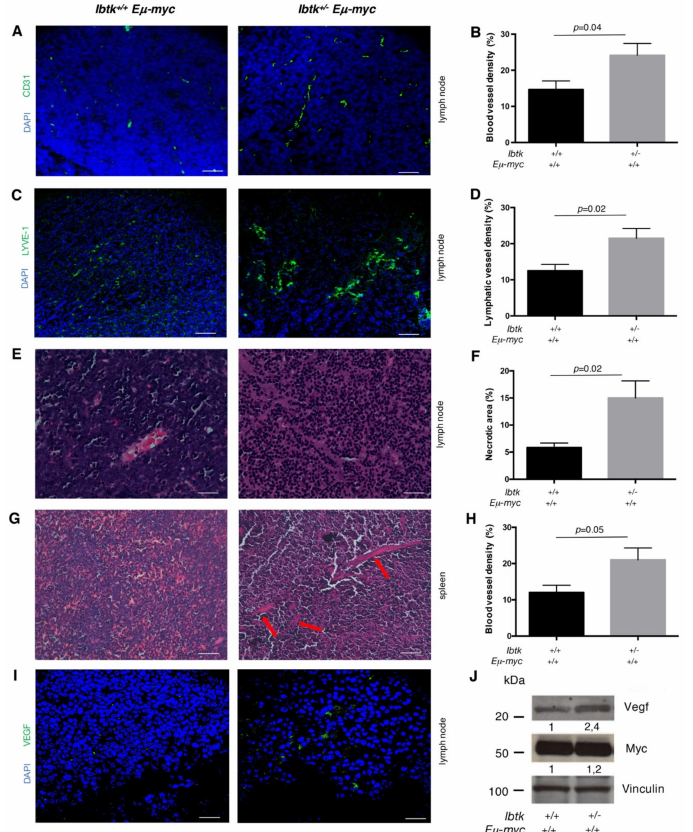
Figure 2. IBTK haploinsu ffi ciency results in increased tumor vascularization and tissue necrosis. A. Sections of tumor lymph nodes of Ibtk +/+ E µ -myc and Ibtk +/ - E µ -myc mice stained for CD31 (green) to visualize blood vessels, and analyzed by confocal microscopy. A representative image is shown. Scale bars: 150 µ m. Magnification 200 × . B. Quantitation of blood vessel density in cancerous lymph nodes of Ibtk +/+ E µ -myc ( n = 6) and Ibtk +/ - E µ -myc ( n = 6) mice. Values are the mean ± SEM. C. Sections of tumor lymph nodes of Ibtk +/+ E µ -myc and Ibtk +/ - E µ -myc mice stained for LYVE-1 (green) to visualize lymphatic vessels, and analyzed by confocal microscopy. A representative image is shown. Scale bars: 150 µ m. Magnification 200 × . D. Quantitation of the lymphatic vessel density in the tumor lymph nodes of Ibtk +/+ E µ -myc ( n = 6) and Ibtk +/ - E µ -myc ( n = 6) mice. Values are the mean ± SEM. E. Sections of tumor lymph nodes stained by hematoxylin / eosin. Representative images of tumor tissues are shown. Scale Bars: 75 µ m. Magnification 400 × . F. Quantitation of necrosis levels was estimated as a percentage of the total area of tumor lymph nodes of Ibtk +/+ E µ -myc ( n = 6) and Ibtk +/ - E µ -myc ( n = 6) mice. Values are the mean ± SEM. G. Spleen sections of sick Ibtk +/+ E µ -myc and Ibtk +/ - E µ -myc mice stained by hematoxylin / eosin. Red arrows indicate marked vascularization in Ibtk +/ - E µ -myc mice. Scale bars: 150 µ m. Magnification 200 × . H. Quantitation of the vessel density in the spleen of Ibtk +/+ E µ -myc ( n = 6) and Ibtk +/ - E µ -myc ( n = 6) sick mice. Values are the mean ± SEM. I . Sections of tumor lymph nodes of Ibtk +/+ E µ -myc and Ibtk +/ - E µ -myc mice stained for VEGF (green) and analyzed by confocal microscopy. A representative image is shown. Scale Bars: 50 µ m. Magnification 630 × . J. Immunoblot analysis of VEGF, Myc, and vinculin expression in the protein extracts of B cells isolated from the tumor lymph nodes of Ibtk +/+ E µ -myc and Ibtk +/ - E µ -myc mice. Protein bands were normalized to the corresponding vinculin